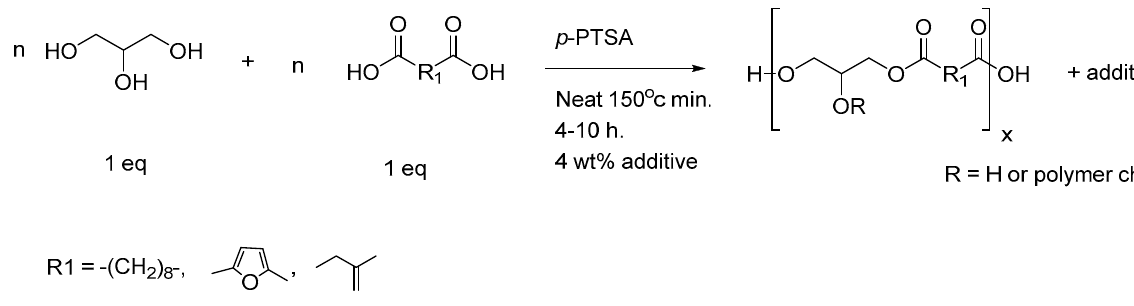
Figure 2. Modified synthetic pathway for producing poly(glycerol-co-diacids) composites (R = hydrogen or polymer chain).